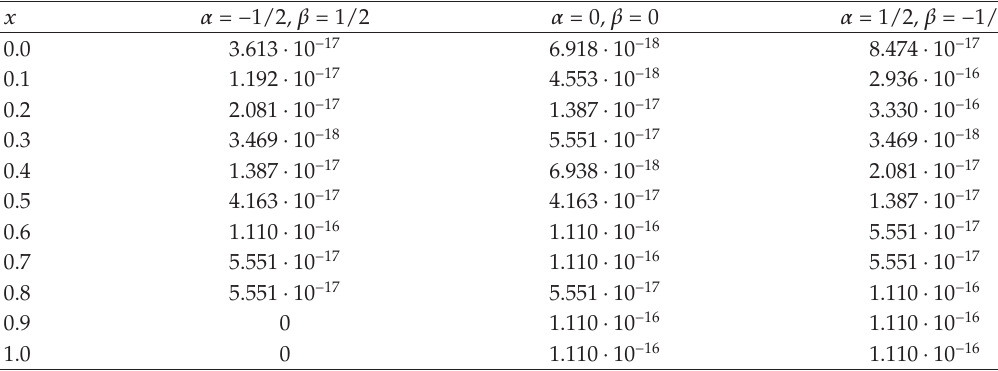
Table 5: Absolute error using SJC method for N (cid:9) 14 Example 6.5.